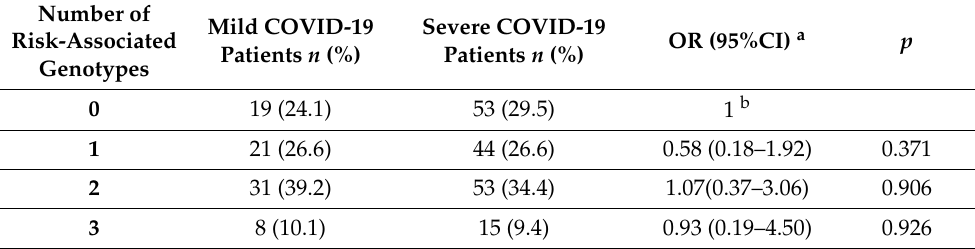
Table 6. The association of risk-associated genotypes with risk for severe COVID-19. Number of Risk-Associated